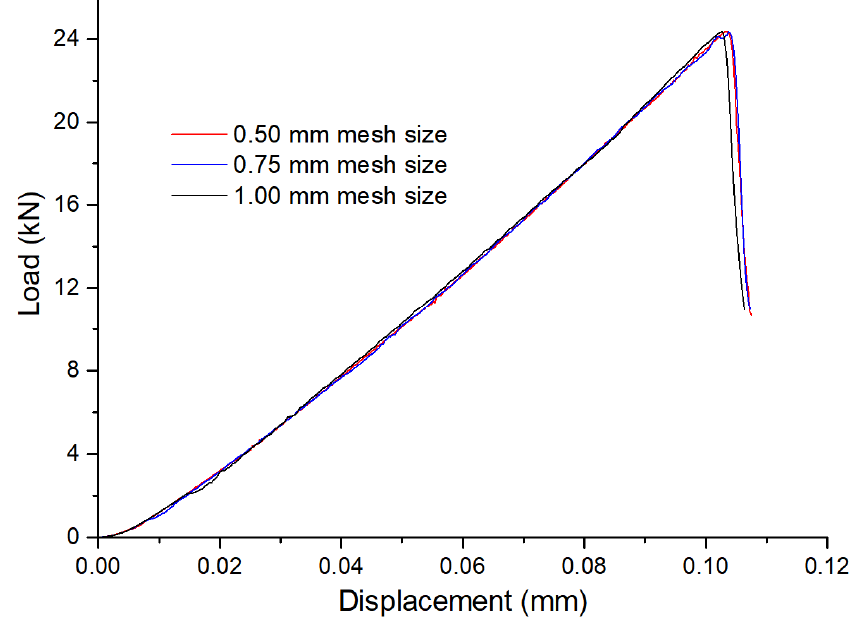
Figure A3. The influence of mesh size on the loading curve for the Type III Brazilian testing.